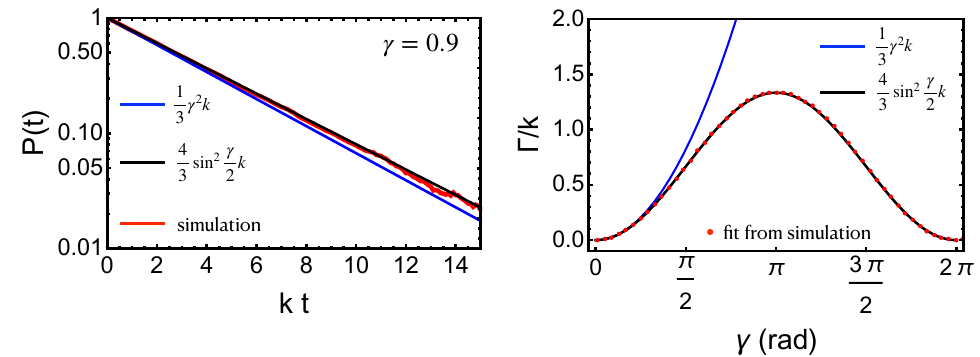
Figure 2. (Color online) Left panel: the spin polarization as a function of time when relaxation is due to spin–orbit coupling using γ = 0.9. Red: simulation; black: exact spin polarization calculated using a multiple trapping model, strong-collision approximation, and γ of constant magnitude, but random orientation; blue: small-angle approximation for the spin relaxation rate. Right panel: Spin relaxation rate, Γ , determined from the simulation (red points), exact solution (black line), and approximate solution (blue line). k = 1 was chosen for the hopping rate for all points and